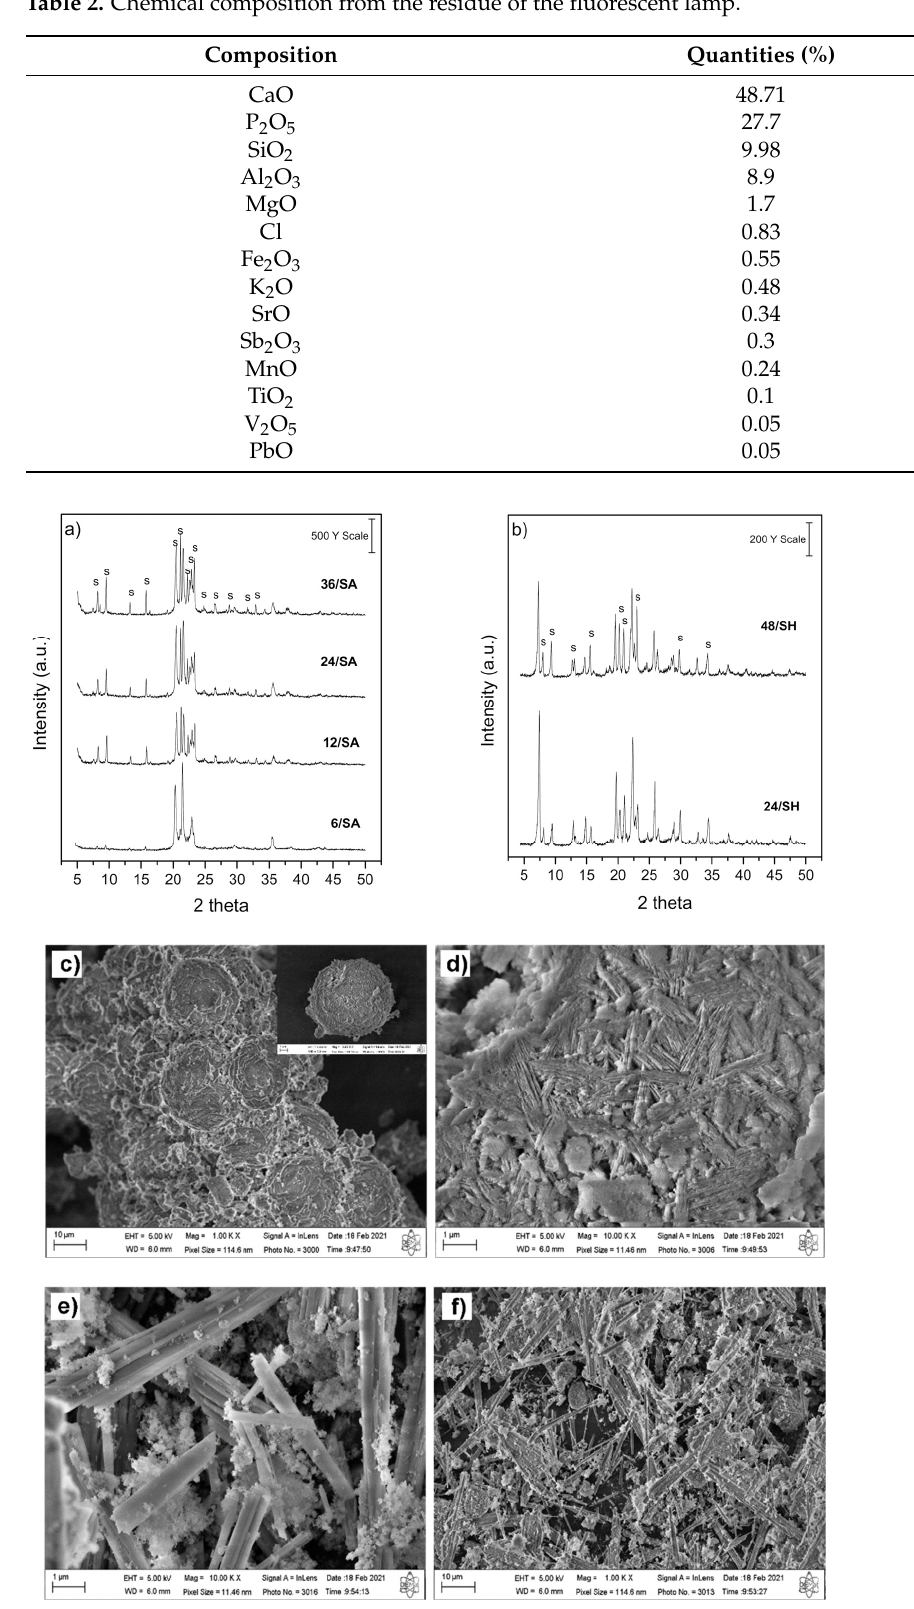
Figure 2. XRD patterns of the samples with different crystallization times: ( a ) SAPO-11 using aluminum oxide; ( b ) SAPO-11 using aluminum hydroxide as Al source. SEM images of ( c , d ) 24/SA and ( e , f ) 24/SH. (S) SAPO-11.